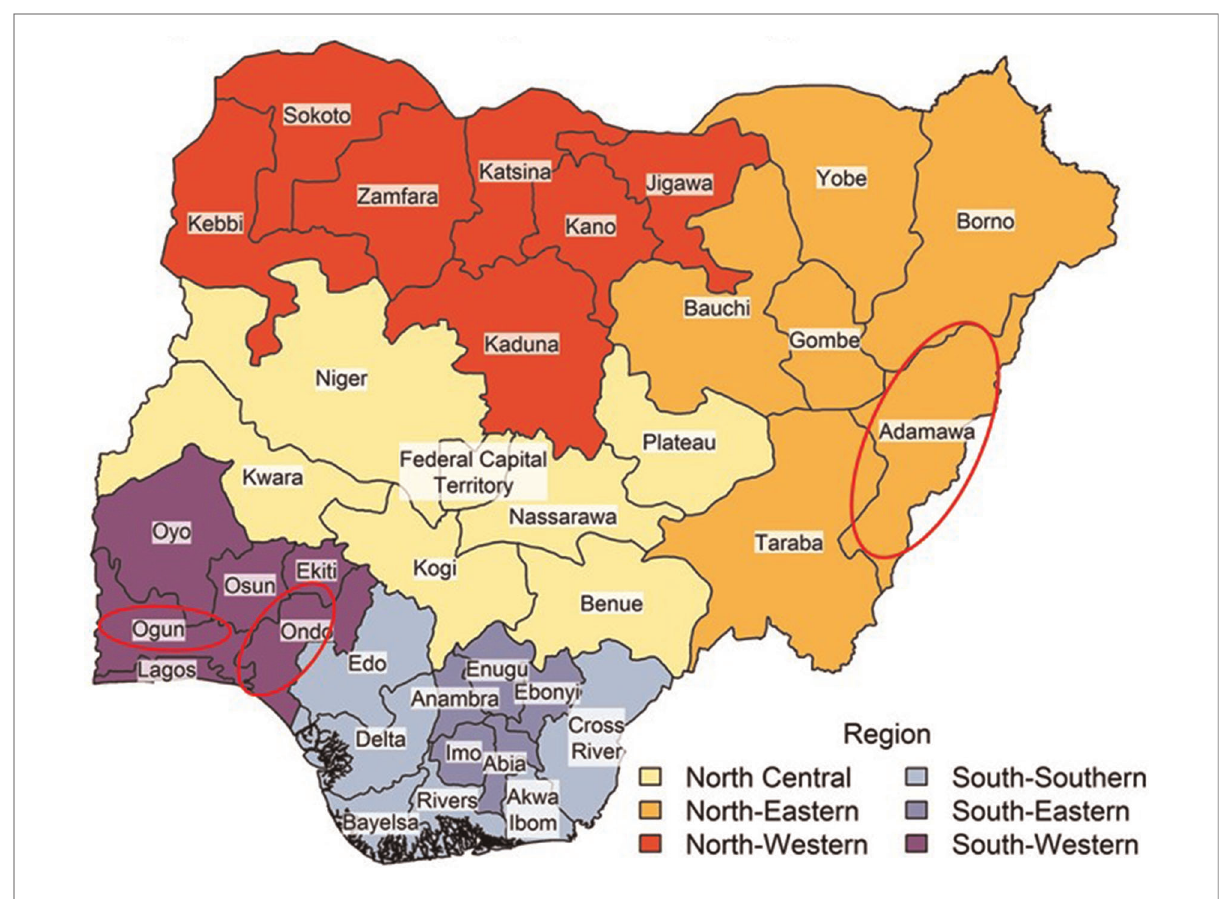
FIGURE 1 Map of Nigeria showing the states of Nigeria and the federal capital territory.